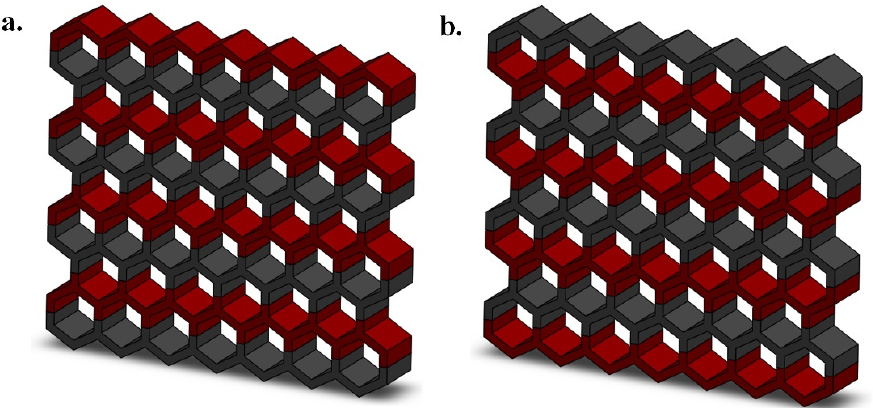
Figure 2. A schematic drawing of two types of dual-material architectured structures based on ( a ) polyamide–thermoplastic co-polymer (PA12–TPC) (sample 6) and ( b ) TPC-PA12 (sample 7). Red and grey colors indicate PA12 and TPC, respectively.